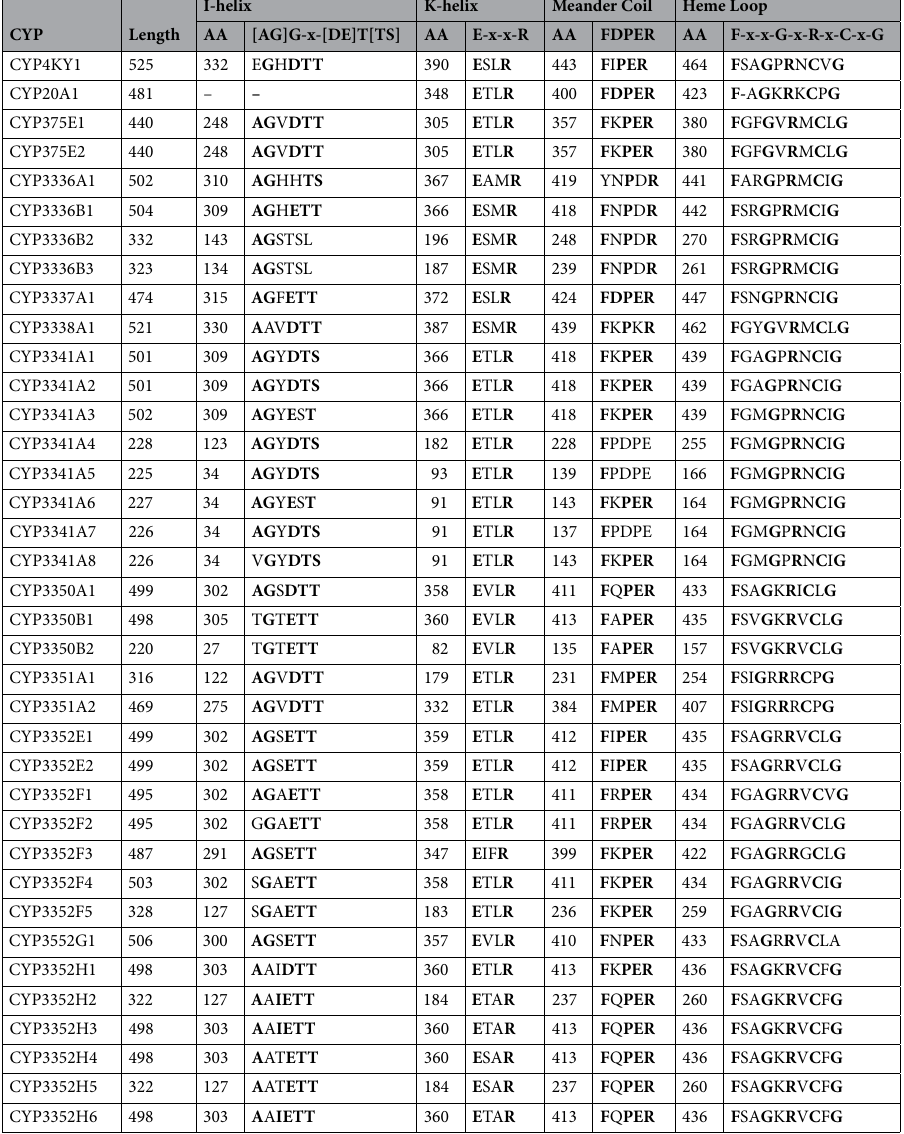
Table 3. The occurrence and position of conserved cytochrome P450 motifs in the A. aurita CYPome. ‘Length’ indicates the total length of the translated protein sequence, and ‘AA’ is the position of the first amino acid residue for each motif. Bolded residues indicate residues that were